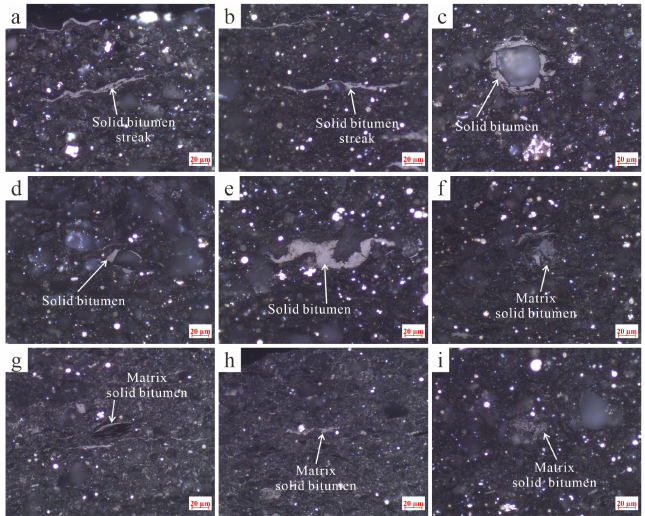
Figure 3. Microphotographs of solid bitumen in the Wufeng–Longmaxi Formations from southern Sichuan Basin. ( a ) Type A, filled in pores (L204-34, 3843.70 m, BR o = 2.687%); ( b ) Type A, filled in pores (Y101H4-4-44, 4142.63 m, BR o = 3.091%) ( c ) Type A, attached to the edge of mineral grain (L205-26, 4034.82 m, BR o = 3.031%); ( d ) Type A, attached to the edge of mineral grain (Y101H4-4-30, 4133.96 m, BR o = 2.213%); ( e ) Type A, showing mosaic structure (L204-17, 3825.79 m, BR o = 3.291%); ( f ) Type B, matrix solid bitumen cracked into angular particles with high reflectance (W213-1, 3745.34 m, BR o = 2.847%); ( g ) Type B, distributed in the matrix pores (N222-4, 4327.14 m); ( h ) Type B, distributed in the matrix pores (N222-4, 4327.14 m, BR o = 2.673%). ( i ) Aggregate formed by Type B particles (L204-17, 3825.79 m, BR o =